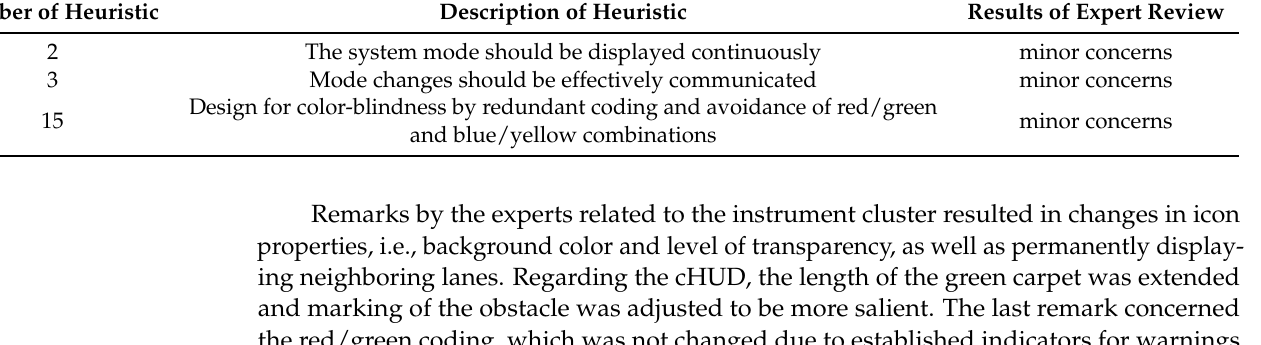
Table 1. Results of the expert review about the first HMI concept. Number of Heuristic Description of Heuristic Results of Expert Review The system mode should be displayed continuously Mode changes should be effectively communicated minor concerns Design for color-blindness by redundant coding and avoidance of red/green minor and blue/yellow combinations